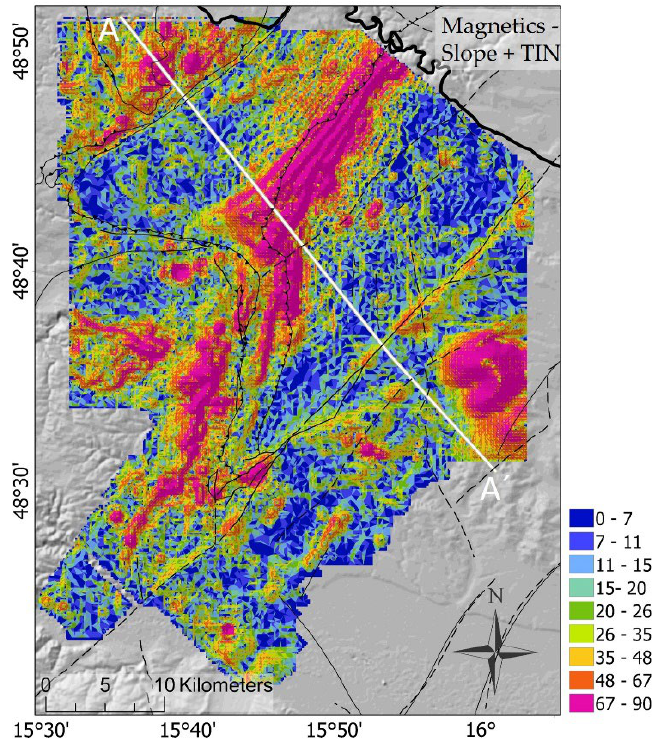
Figure 7. Slope amplitude [in degrees] of magnetic total intensity (triangulated field) with z- factor 20. Background map: Lidar image with a 10 × 10 m resolution. Background map: Lidar image with a 10 × 10 m